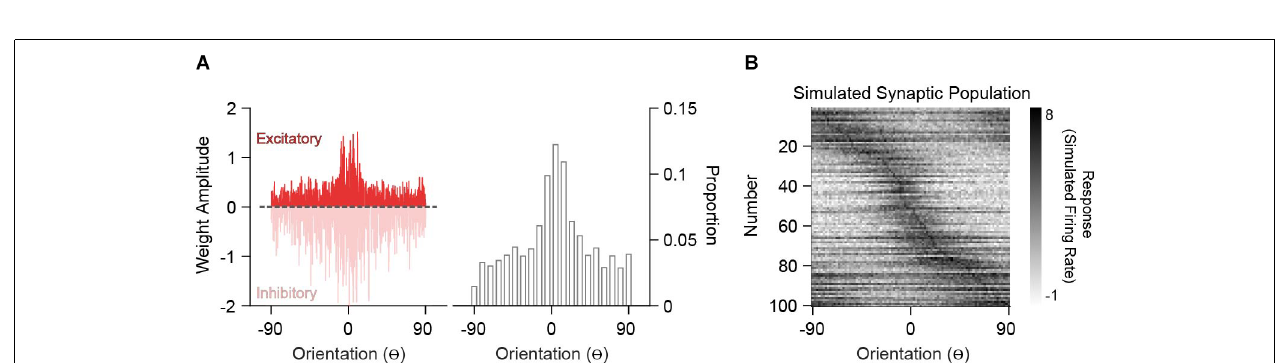
FIGURE 4 | Simulation of synaptic populations from decoder neuron weight distributions. (A) Example weight distribution for a single decoder neuron tuned to 0 o (left). Ordinates are orientation preference, restricted between − 90 o and 90 o . The dashed line separates excitatory (positive) and inhibitory (negative) weights. Excitatory weight distribution over the input population is transformed into a frequency distribution, whereby greater amplitude equates to a greater frequency of occurrence (right). (B) Example simulated synaptic population ( n = 100 spines) from the weight distribution in (A) . Shown are the orientation tuning curves of each simulated synapse (normalized).